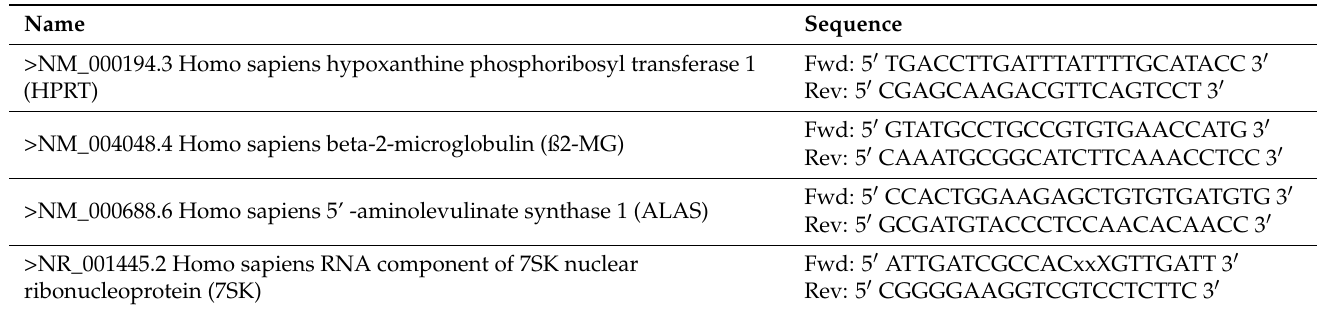
Table 1. Primers used in this